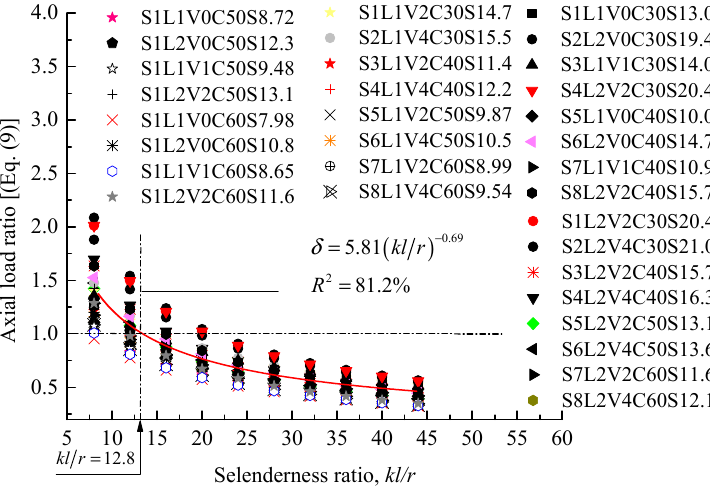
Figure 6. Proposed slenderness limit for FRP-confined concrete columns.